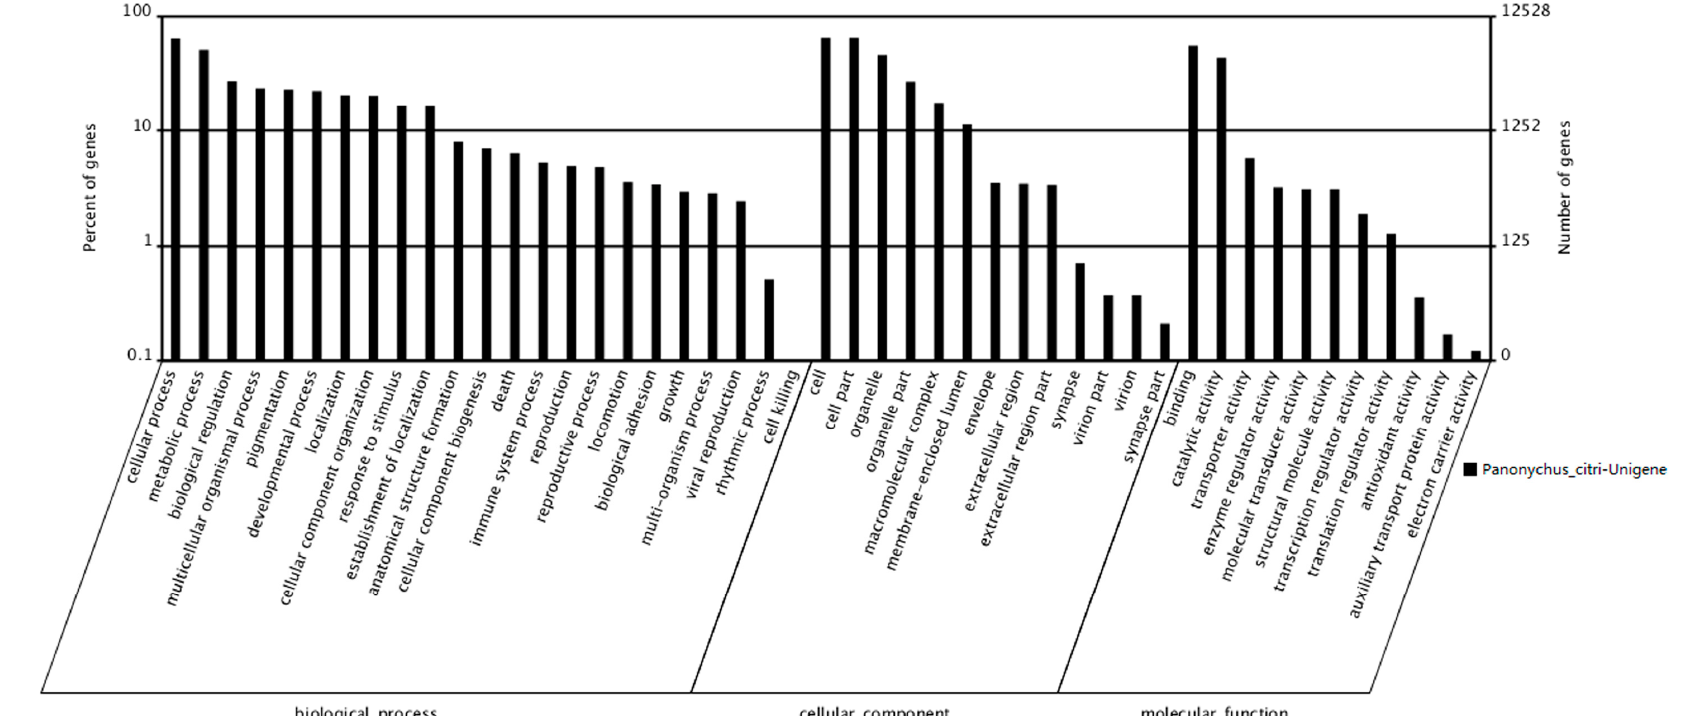
Figure 3. Gene Ontology classifications of assembled unigenes. A total of 12,528 unigenes were categorized into three main categories: biological process, cellular component and molecular function.